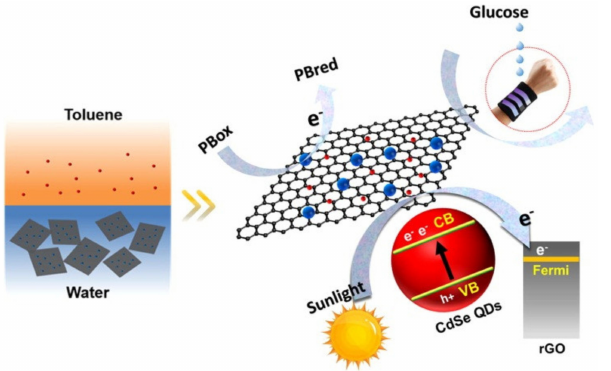
Figure 10. Schematic of PB–rGO–QDs film preparation through experimental method (reprinted with permission from Ref. no. [102], copyright 2022,